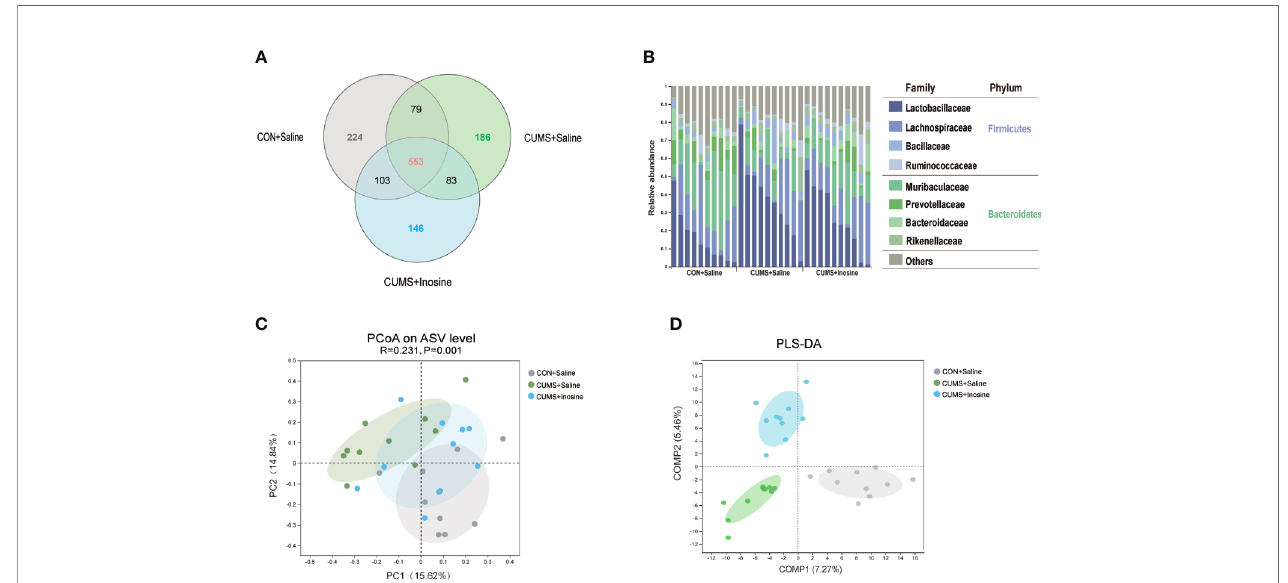
FIGURE 3 | Comparison of gut microbiota composition among CON+saline, CUMS+saline, and CUMS+inosine groups. (A) Venn diagram showing ASV richness and the overlap of CON+saline (grey), CUMS+saline (green), and CUMS+inosine (blue) groups. (B) The relative abundance of ASVs assigned to family and phylum levels. (C) The principal coordinate analysis of samples along with principal components 1 and 2, which explained 14.84% and 15.62% of the total variance, respectively. (D) Partial least squares discriminant analysis plot of gut microbiota among three groups: CON+saline group (grey dots), CUMS+saline group (green dots), and CUMS+inosine group (blue